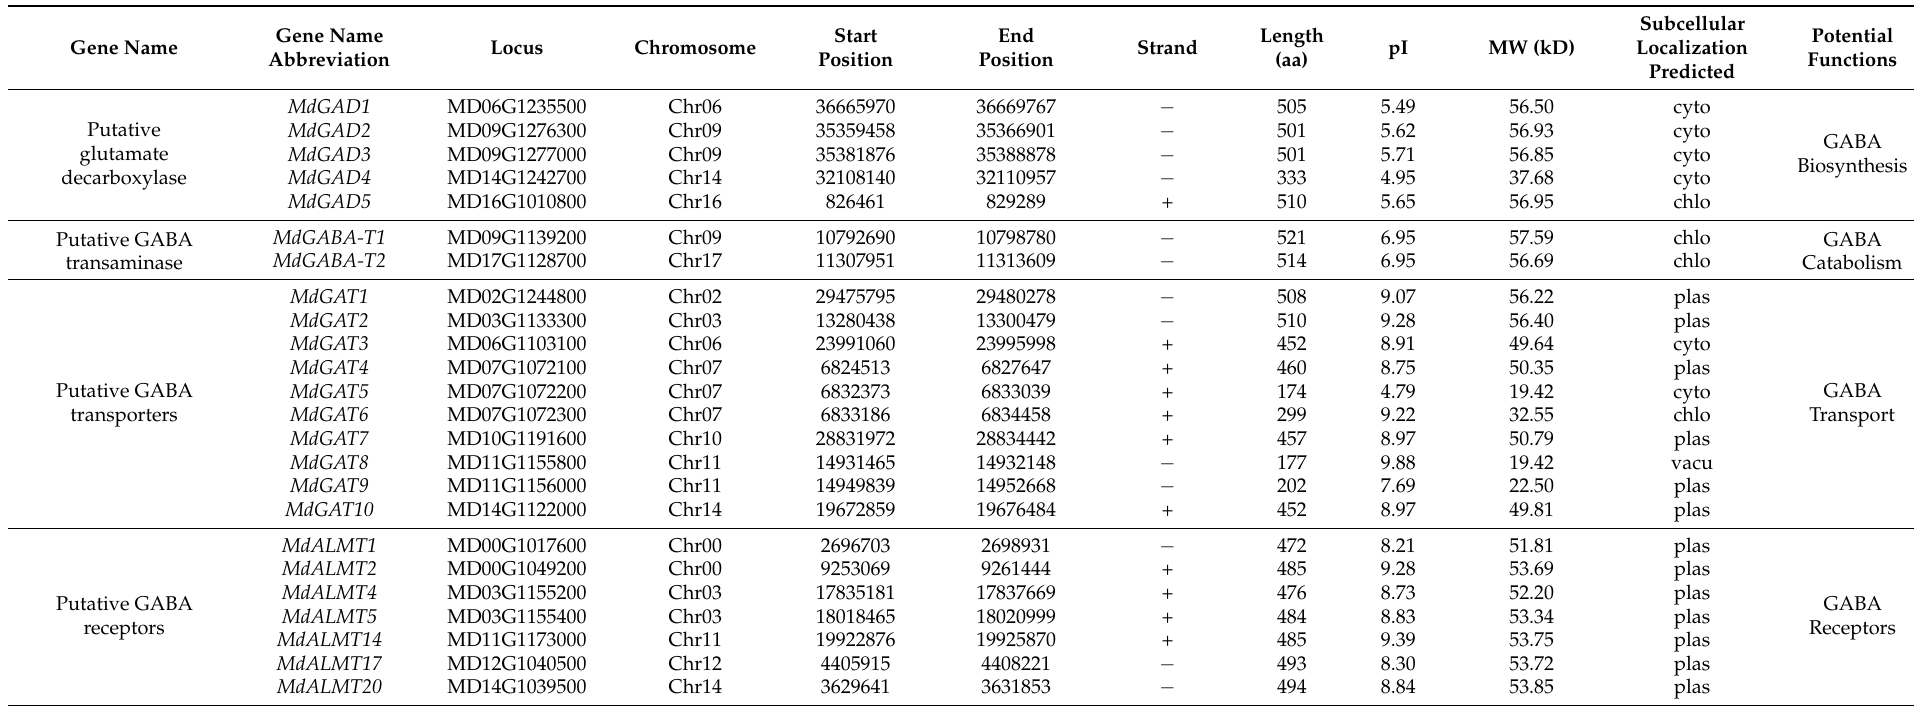
Table 1. GABA pathway genes identified in this study. (cyto: cytoplasmic; chlo: chloroplast; plas: integral membrane; vacu: